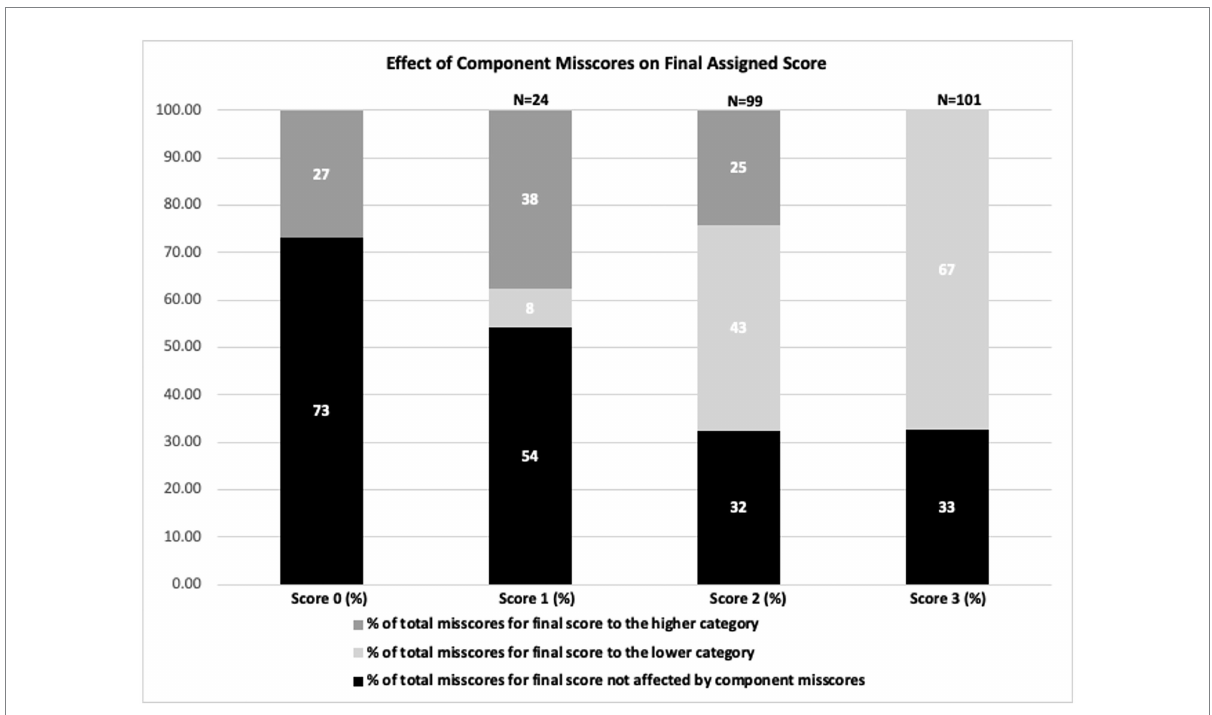
FIGURE 7 Effect of MA component misscores on final assigned score for S5.